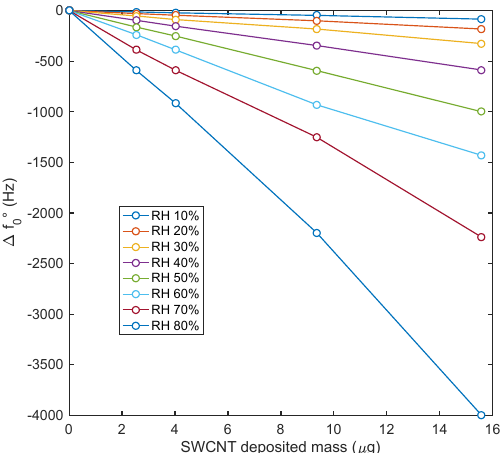
Figure 7. Measured frequency shifts in the SWCNT-deposited mass. The mass is obtained from the frequency shift measurements in dry air of the pristine and functionalized quartz and exploiting Equation (1) as in [9], intended as part 1 of this paper.